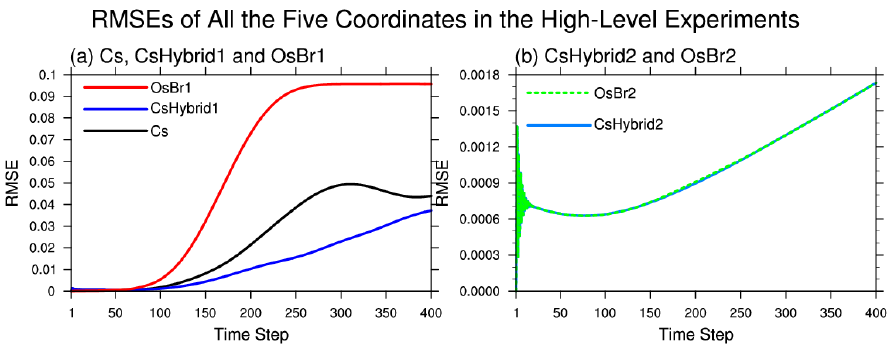
Figure 10. RMSEs of all five experiments with respect to the analytical solution in the Schär-type (high-level) experiments according to the time step calculated by d t =